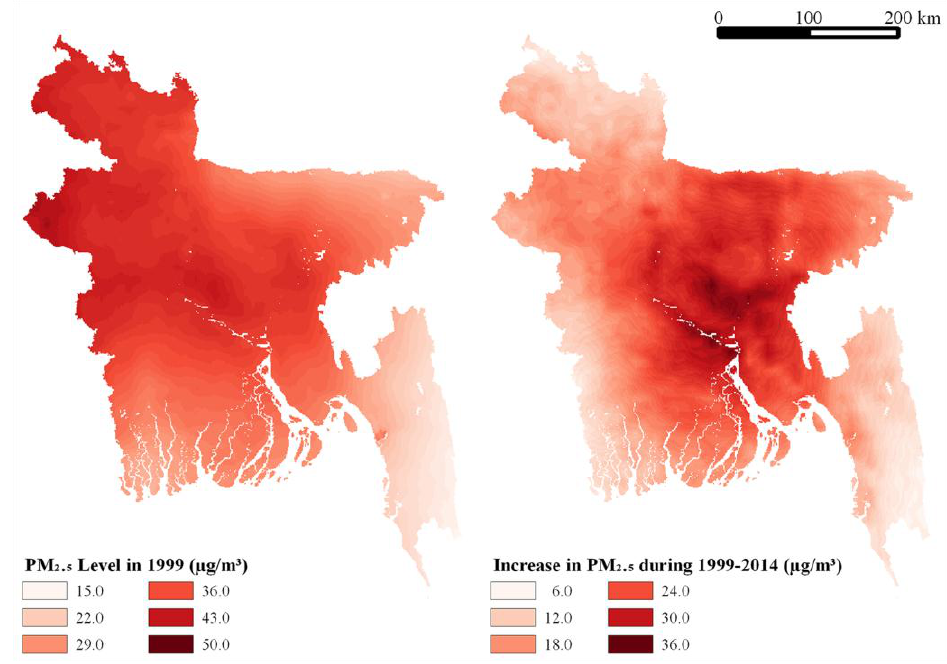
Figure 2. PM 2.5 level (µg/m 3 ) in 1999 (left) and increase in PM 2.5 level (µg/m 3 ) between 1999 and 2014 (right) in Bangladesh.